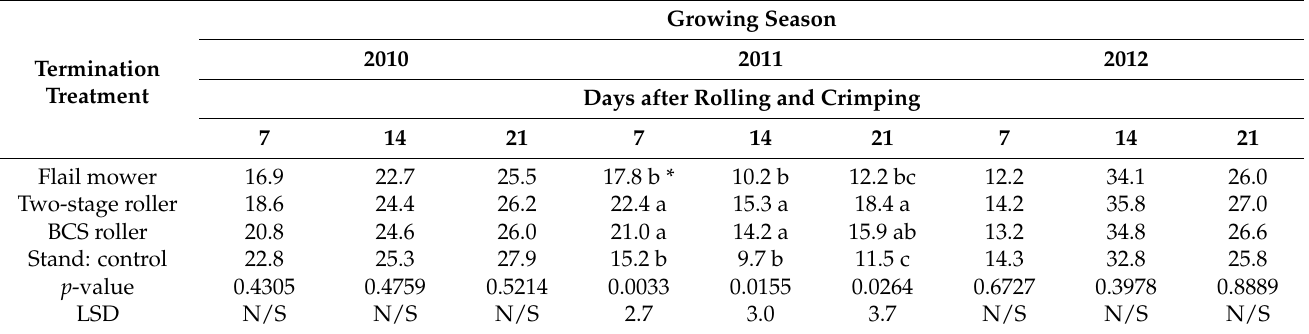
Table 12. Volumetric moisture content (VMC in %) for hairy vetch during three weeks of evaluation for three growing